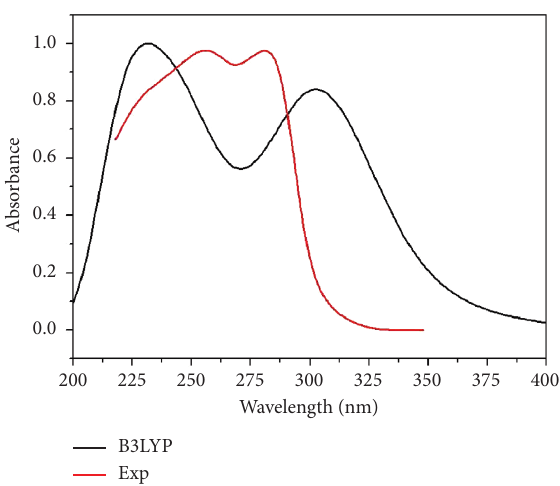
Figure 11: Experimental and predicted UV-vis spectra of the Chrom-D compound. Table 4: Calculated absorption wavelengths λ , excitation energies E , and oscillator strengths f using the TD-B3LYP/311++G(d,p) method in the DMSO solvent.